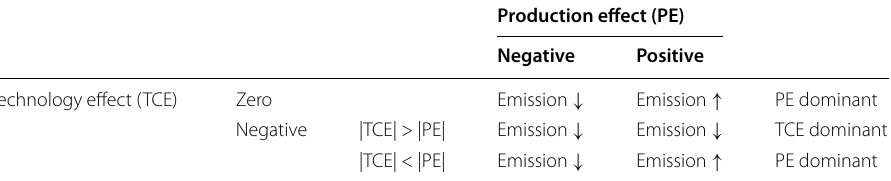
Table 5 Classification of decomposition